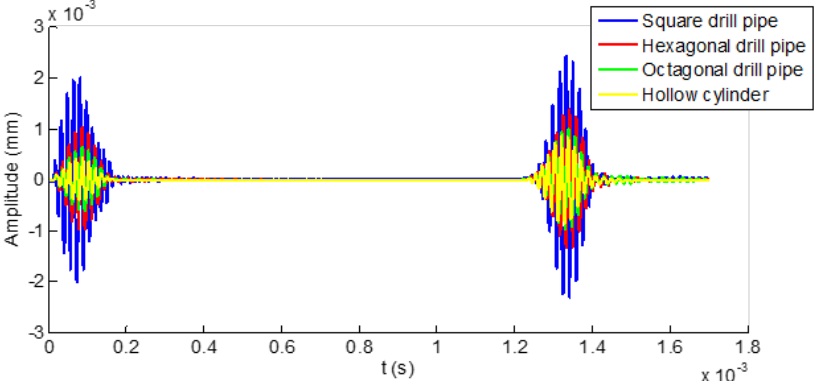
Figure 11. Time domain waveforms received from square, hexagonal, and octagonal drill pipes and the referential hollow cylinder marked by blue, red, green, and yellow curves, respectively.